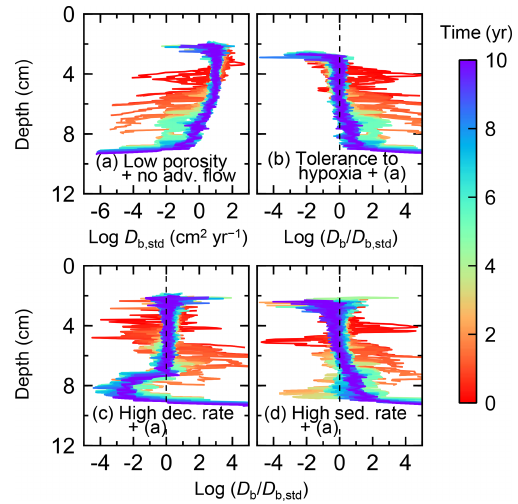
Figure 11. Time evolution of the biodiffusion coefficient ( D b ) ob- tained from 10-year simulations with eLABS. See Sect. 3.2 and cap- tion of Fig. 8 for the details of simulations (a–d) . Note that the D b values are presented only for simulation (a) (denoted as D b , std ); for other simulations (b–d) , the ratios of D b values to those in panel (a) ( D b /D b , std ) are shown to facilitate comparison and dashed vertical lines are references to denote D b = D b , std . Plotted are these val- ues/ratios at 25 model days to 10 model years from the start of the simulations with intervals of 25 model